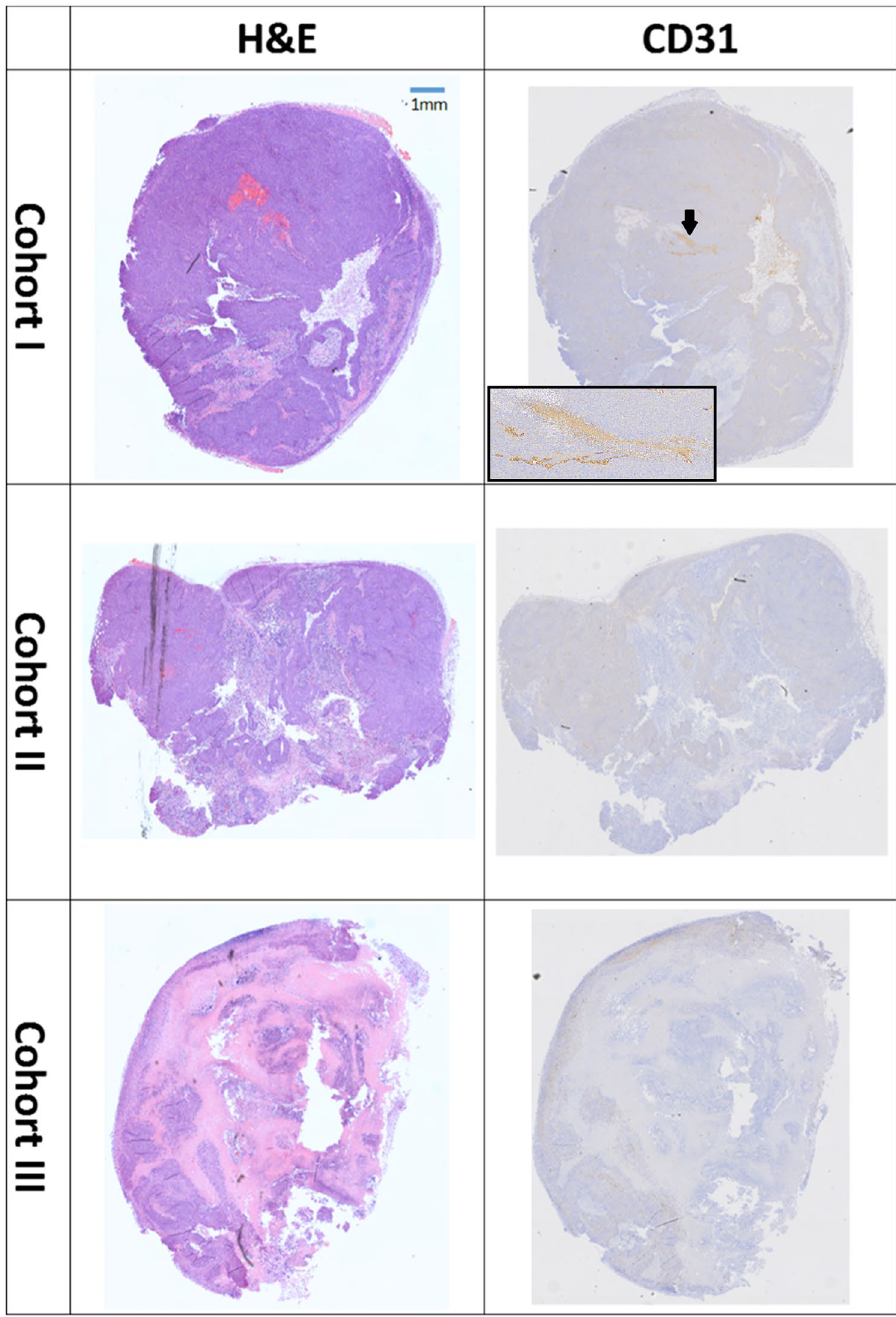
Figure 7. Histological examples of H&E and CD31. In H&E staining (middle column) the purple colour is a viable tissue, pink–necrotic tissue and fat has a white colour. In CD31 (right column) staining the vessels have brown colour as indicated by the black arrow in the upper right image. The inset shows a higher magnification of the